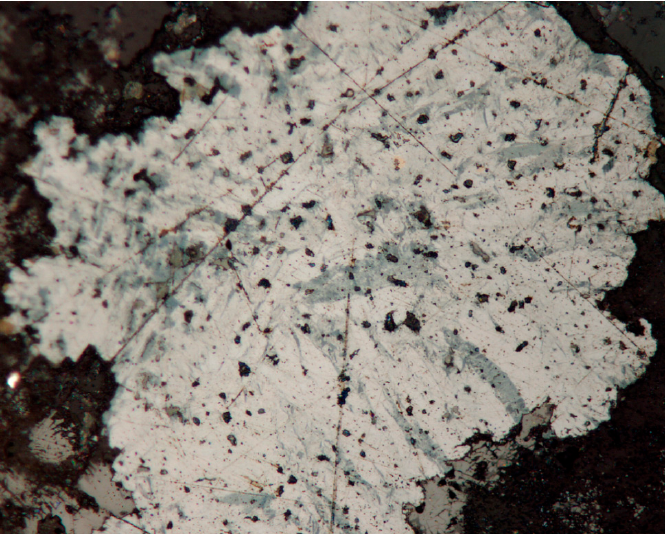
lamellae (light grey). BSE photograph. P ř íbram, a dump of shaft 16. Photo by J. Sejkora and P. (light grey). BSE photograph. Pˇr í bram, a dump of shaft 16. Photo by J. Sejkora and P. Šk á cha. Minerals 2017 , 7 , 91 Škácha.